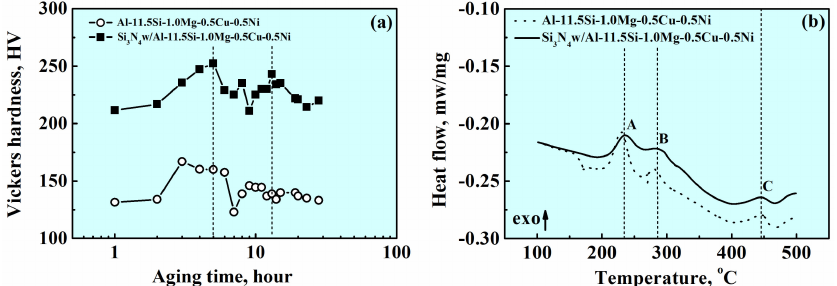
Figure 4. ( a ) Hardness-time curves during age-hardening; and ( b ) Di ff erential scanning calorimeter (DSC) curves for the Al-11.5Si-1.0Mg-0.5Cu-0.5Ni matrix alloy and Si 3 N 4 w / Al-11.5Si-1.0Mg-0.5Cu- 0.5Ni